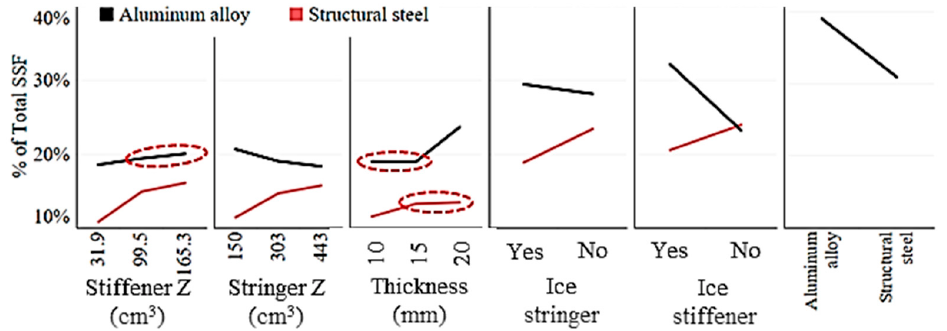
Figure 9. Parametric trends for the Steel and aluminium metal grillage. Red ellipses indicate insignificant parametric variations and represent potential areas for reducing mass.